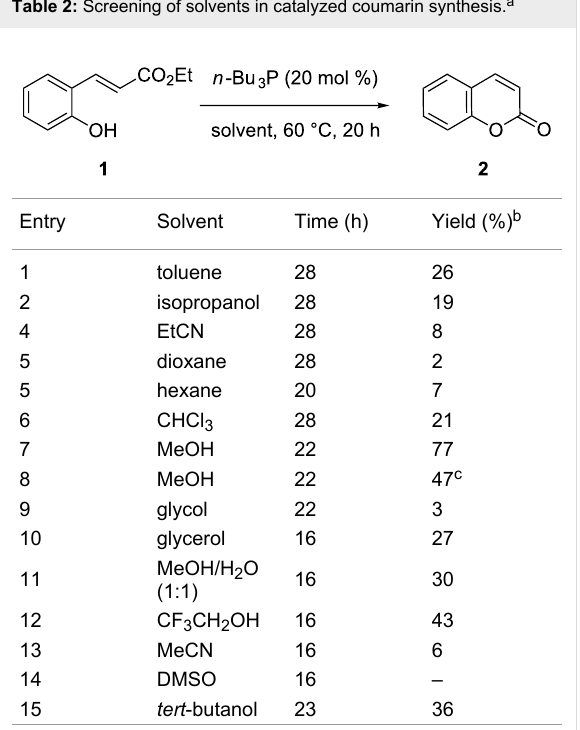
Table 2: Screening of solvents in catalyzed coumarin synthesis.